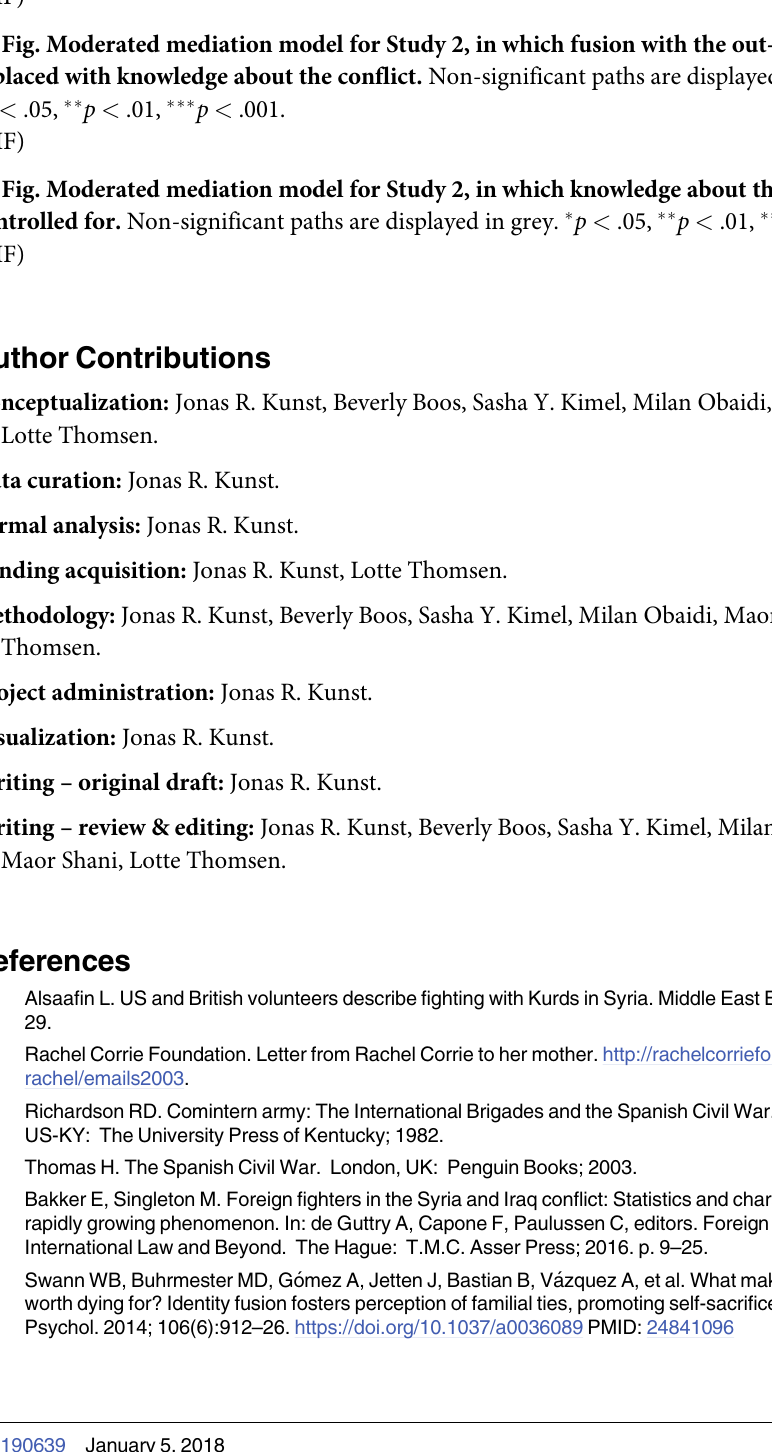
S1 Fig. Reversed mediation model for Study 1. Non-significant paths are displayed in grey. (cid:3) p < .05, (cid:3)(cid:3) p < .01, (cid:3)(cid:3)(cid:3) p < .001. S2 Fig. Moderated mediation model for Study 2, in which fusion with the out-group is replaced with knowledge about the conflict. Non-significant paths are displayed in grey.